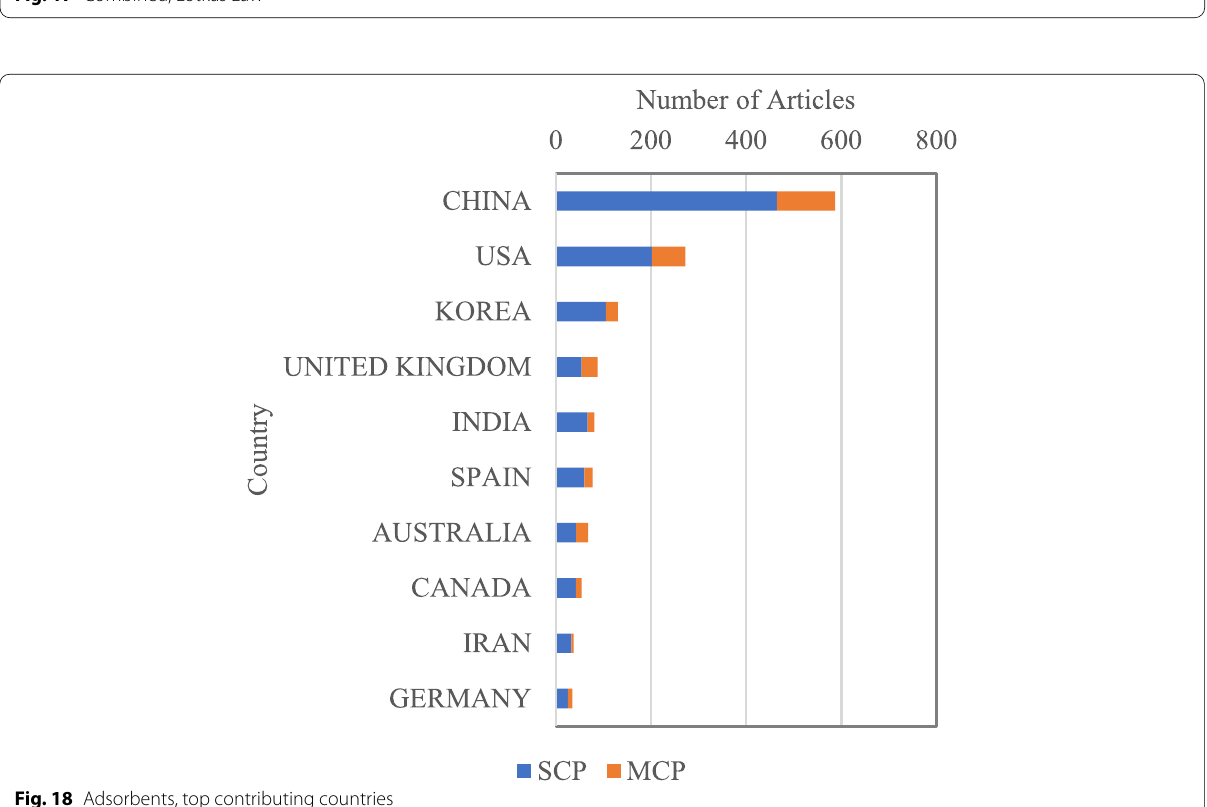
Fig. 17 Combined, Lotkas Law